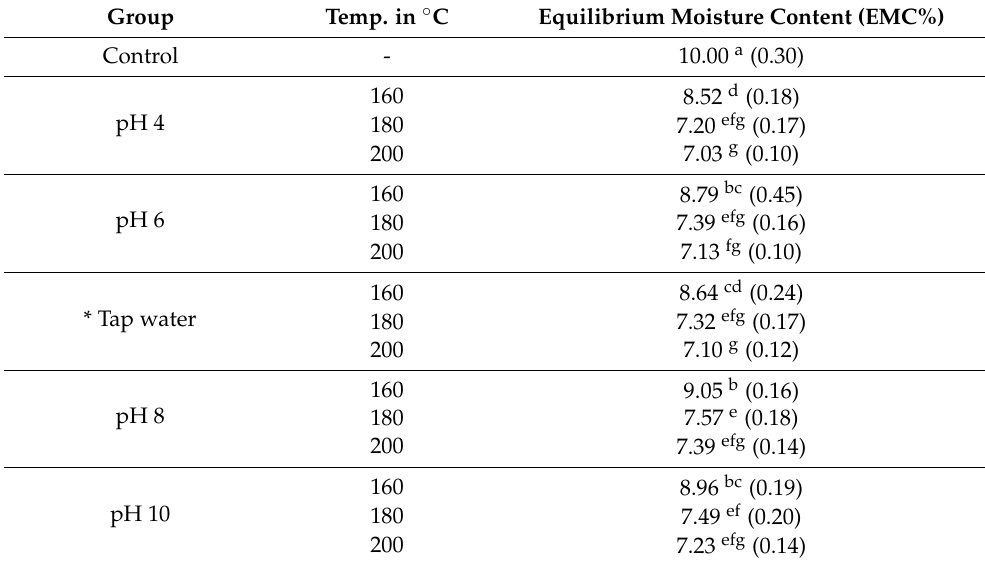
Table 2. EMC of treated and untreated samples of rubberwood at 28 ◦ C and 65% RH. Group Temp. in ◦